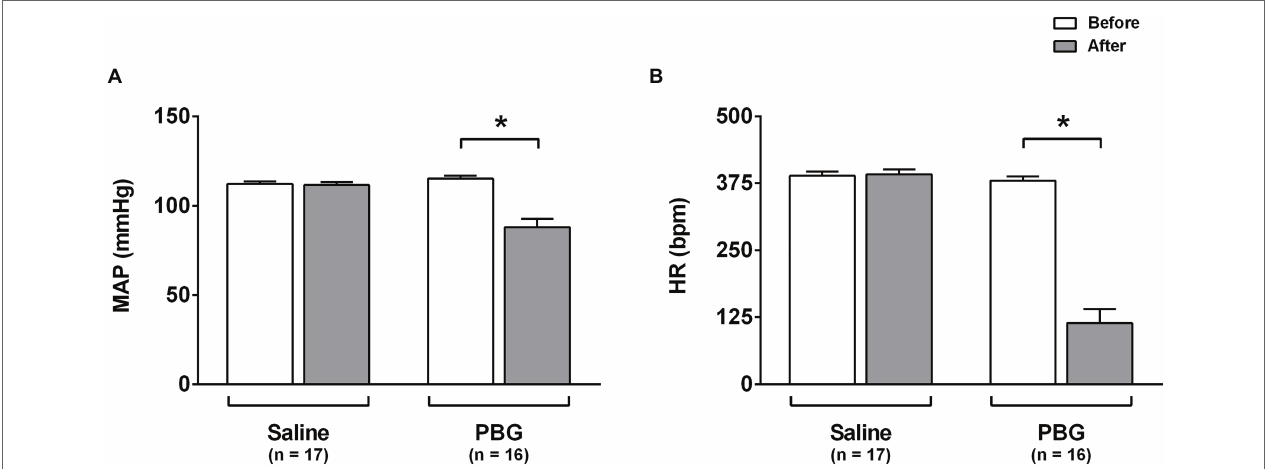
FIGURE 1 | Hemodynamic response to phenylbiguanide. Bar graphs show the mean arterial pressure [MAP (A) ] and heart rate [HR (B) ] at baseline (white bars) and after administration (gray bars) of phenylbiguanide (PBG) or saline. LPS, lipopolysaccharide; PBG, phenylbiguanide; and Sal, saline. * p < 0.05. Two-way ANOVA for repeated measures with Tukey’s post-hoc